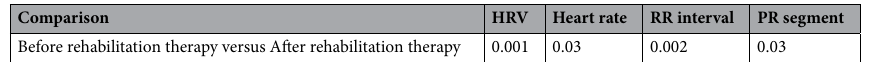
Table 5. Statistical analysis ( p values) between pre-rehabilitation and post-rehabilitation sample measurements.